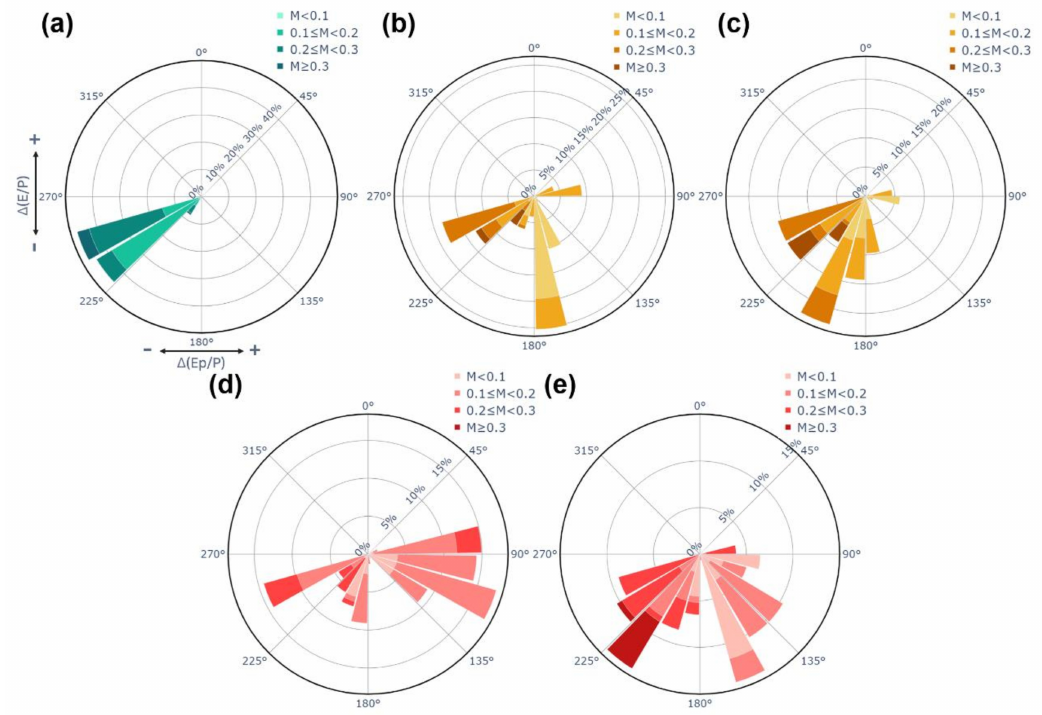
Figure 8. Roses of movement in Budyko space for the 154 watersheds due to changes in aridity index (E p /P) and evaporation index (E/P) between past and current and future periods: ( a ) current period; ( b ) SSP2_NF; ( c ) SSP2_FF; ( d ) SSP5_NF; ( e )